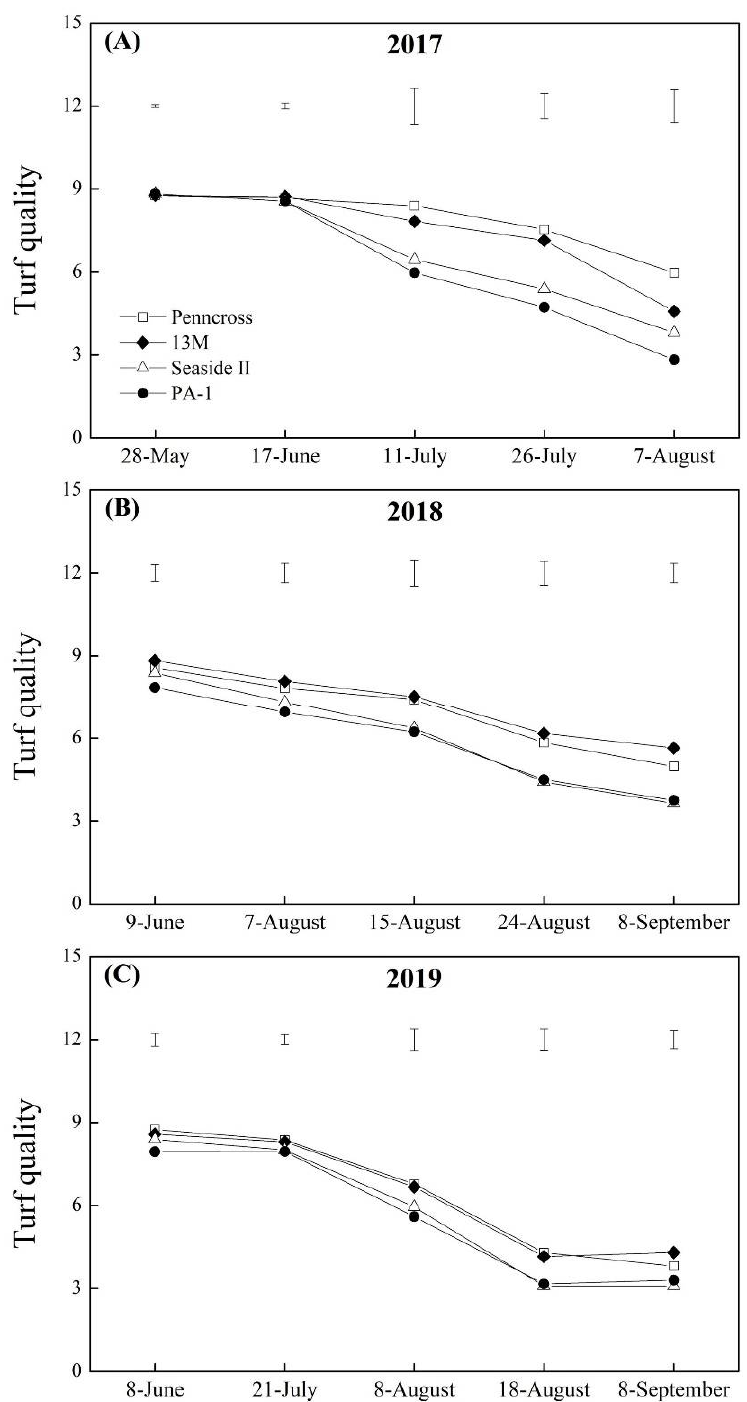
Figure 2. Change in turf quality (TQ) of four different creeping bentgrass cultivars (Penncross, 13M, Seaside II, and PA-1) during summer in ( A ) 2017, ( B ) 2018, and ( C ) 2019. Vertical bars above curves indicate least significant difference (LSD) values ( p < 0.05) at a given day.